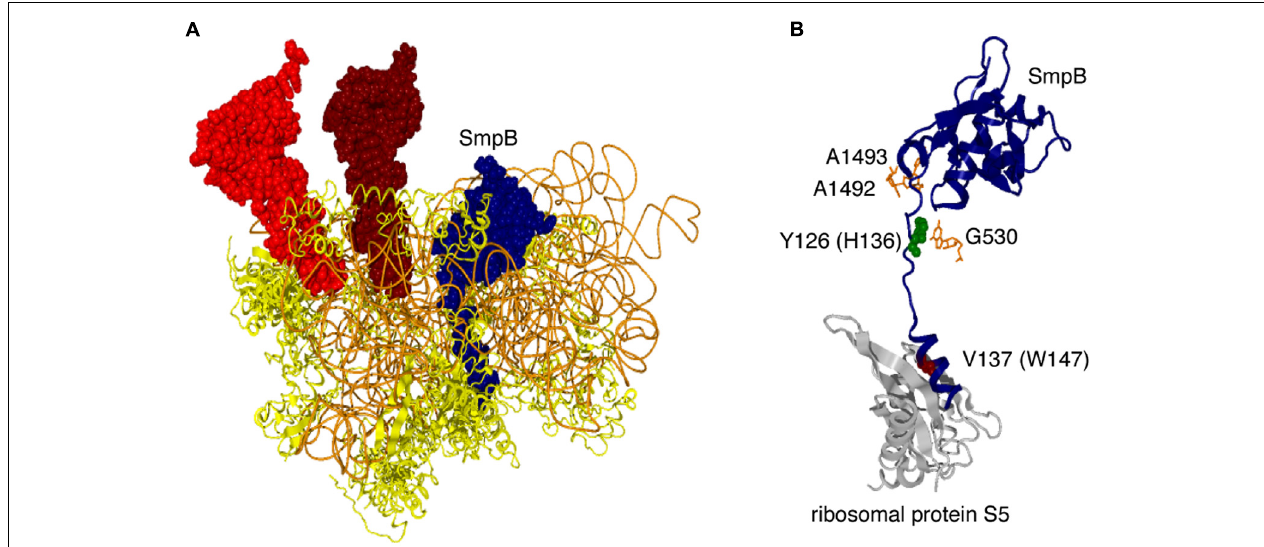
FIGURE 4 | Location of SmpB in a pre-accommodation state complex of trans -translation. (A) SmpB (dark blue, space-filling model), P-site tRNA (brown, space-filling model), E-site RNA (red, space-filling model), 16S rRNA (light brown, wire model), and the ribosomal proteins (yellow, ribbon model) in a crystal structure of T. thermophilus ribosome in complex with a tmRNA fragment, SmpB, EF-Tu · GDP and kirromycin (PDB ID: 4ABR), which mimics the pre-accommodation state of trans -translation (Neubauer etal., 2012), are